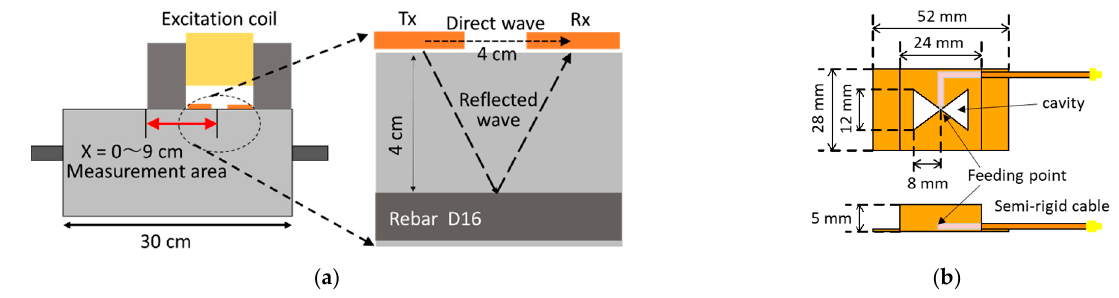
Figure 6. Measurement setup for VDR in concrete: ( a ) Antenna arrangement ( b ) Configuration of used antenna. Table 2. Measurement setting of network analyzer and characteristics of image canceling mixer.